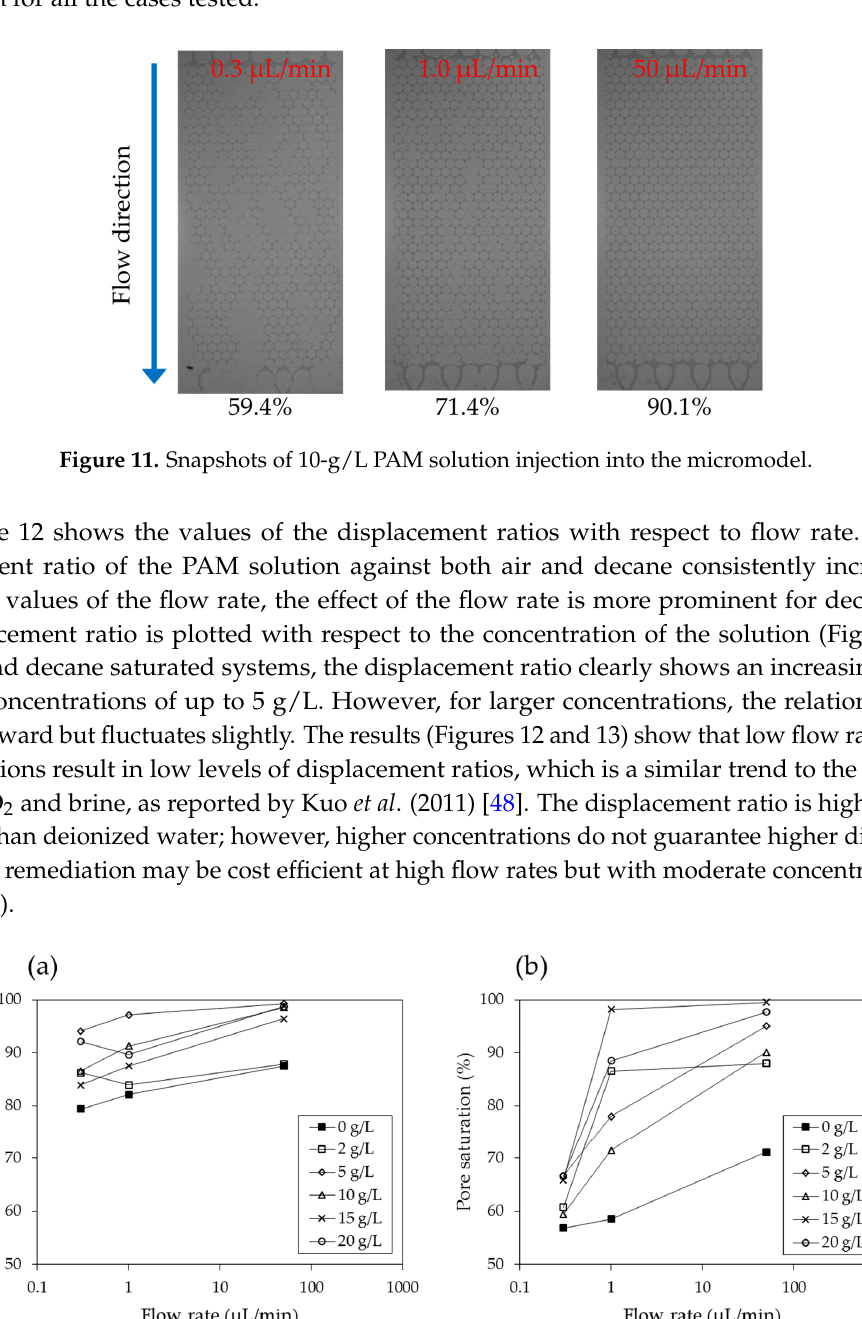
Figure 12. Displacement ratio with respect to flow rate in ( a ) an air saturated model and ( b ) a decane saturated model.